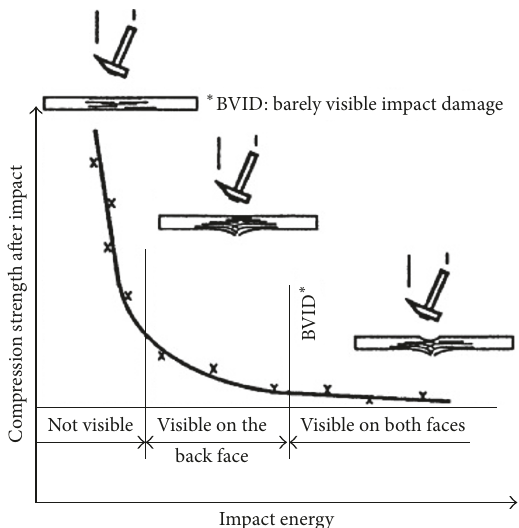
Figure 1: Effect of BVID on compression after impact strength